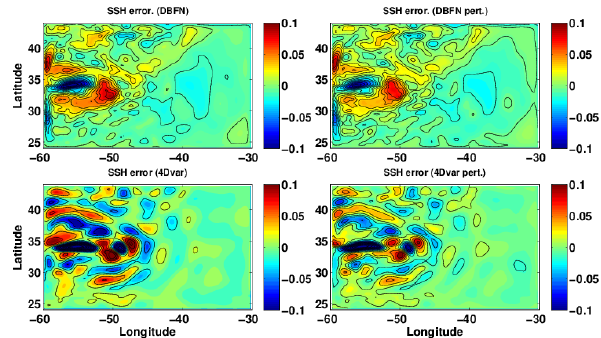
Figure 15. SSH error (analysis–truth) from DBFN experiments (top panels) and 4Dvar experiments (bottom panels). Right panels show the results obtained from the perturbed